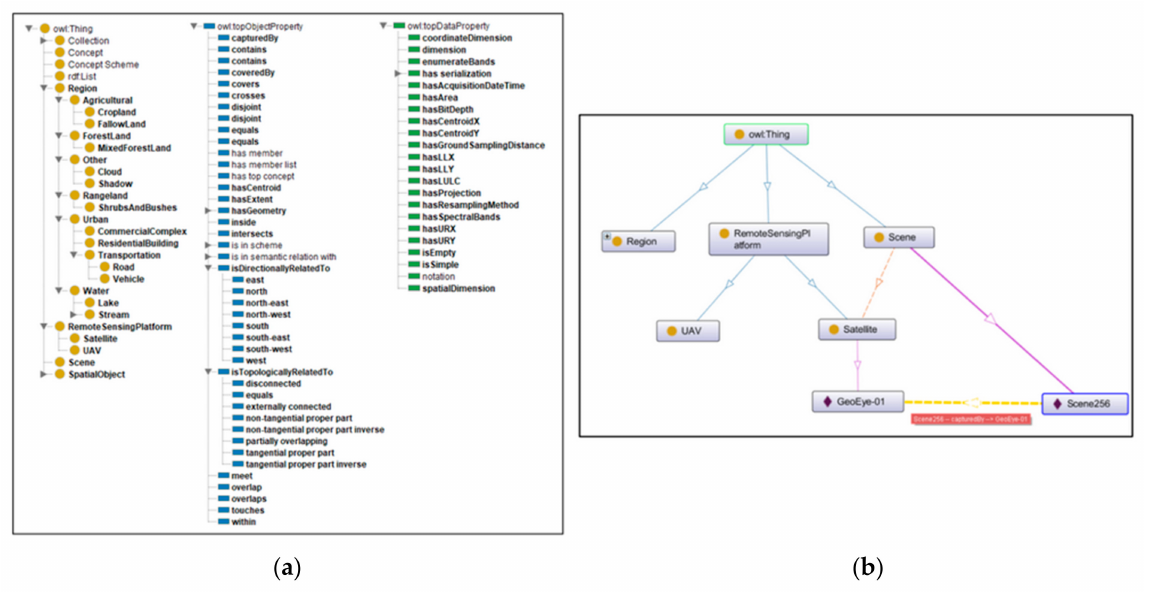
Figure 4. ( a ) Snapshot of the Classes Hierarchy, Object and Data Properties in the Remote Sensing Scene Ontology (RSSO) extending the GeoSPARQL ontology. ( b ) Visualization of a scene instance captured by the GeoEye-01 Satellite as modeled in the Remote Sensing Scene Ontology (RSSO).